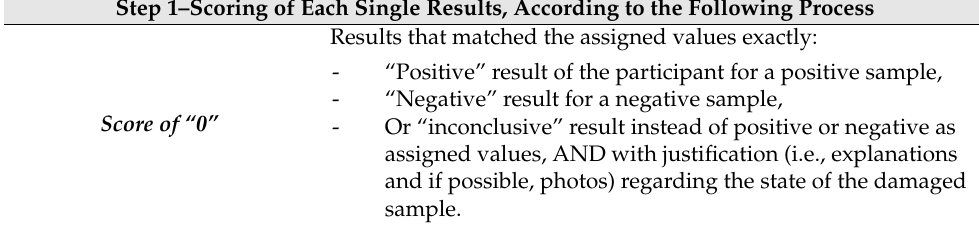
Table A2. Methodology of the score